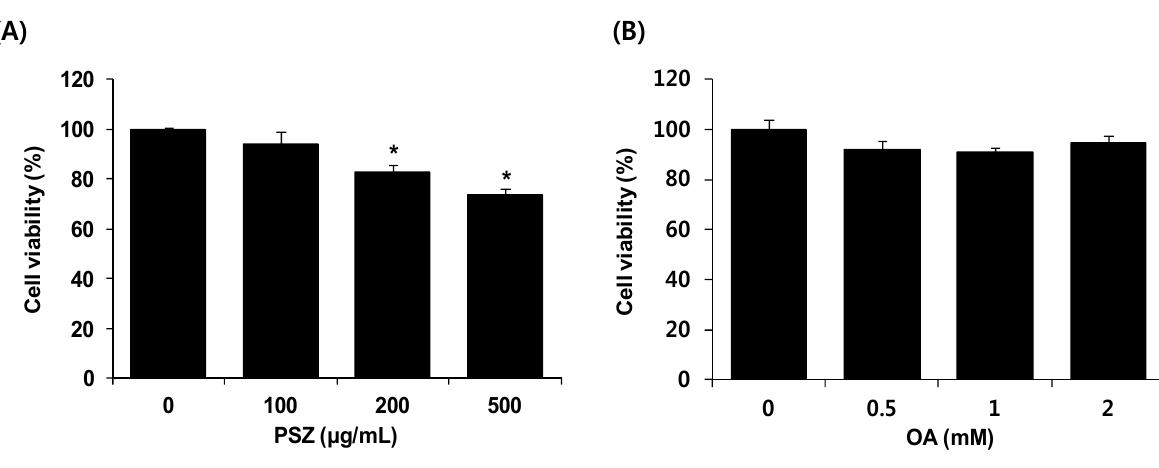
Figure 1. Cell viability effect of Pinus densiflora Sieb. et Zucc. (PSZ) in HepG2 cells. ( A ) HepG2 cells were treated with PSZ (100, 200 and 500 μ g/mL) and ( B ) HepG2 cells were treated with oleic acid (OA; 0.5, 1 and 2 mM). After treatment for 24 h, cell viability was quantified by measuring intracellular levels of ATP. Bars represent the mean ± SEM of three experiments done in